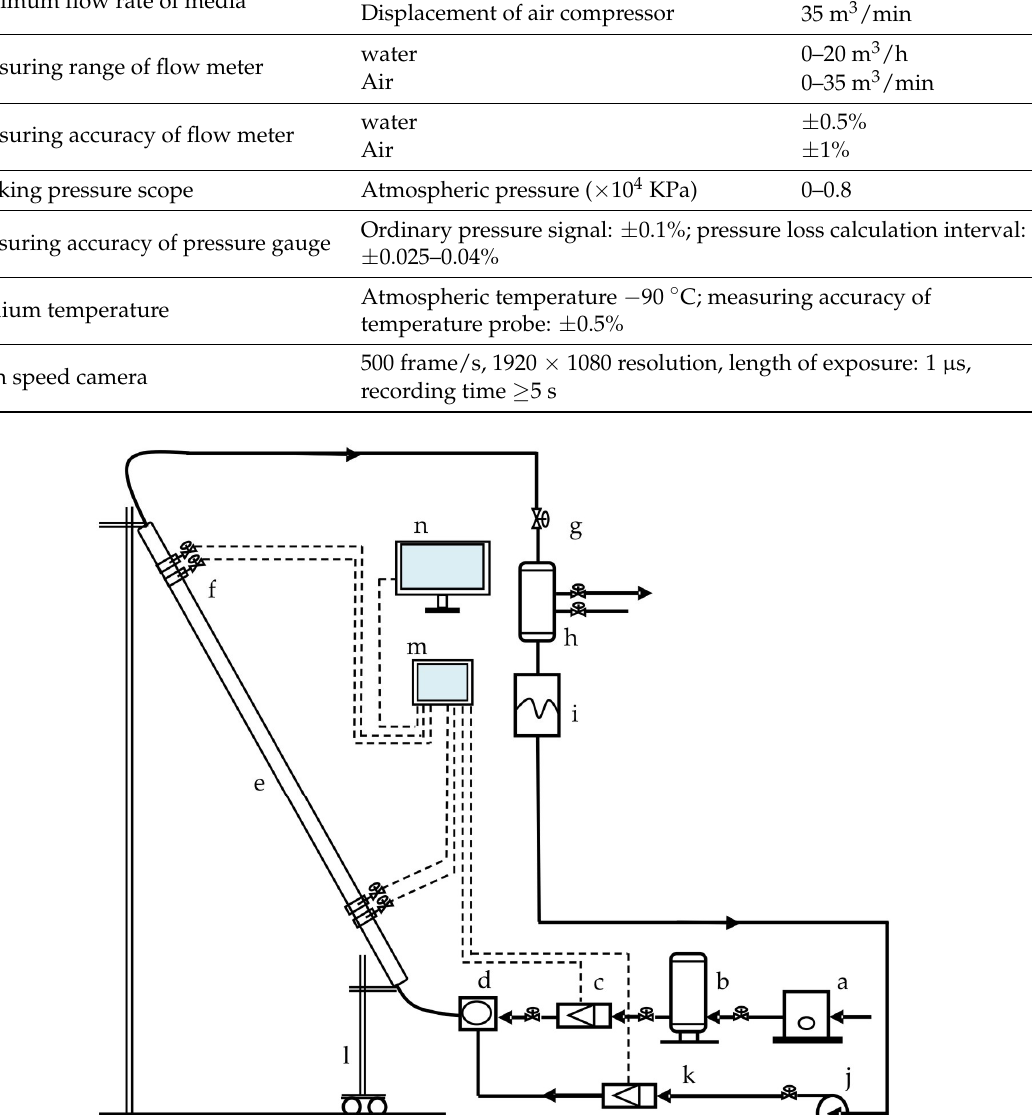
Figure 1. Flow diagram of experiment: (a) air compressor; (b) gas storage tank; (c) gas flow meter; (d)